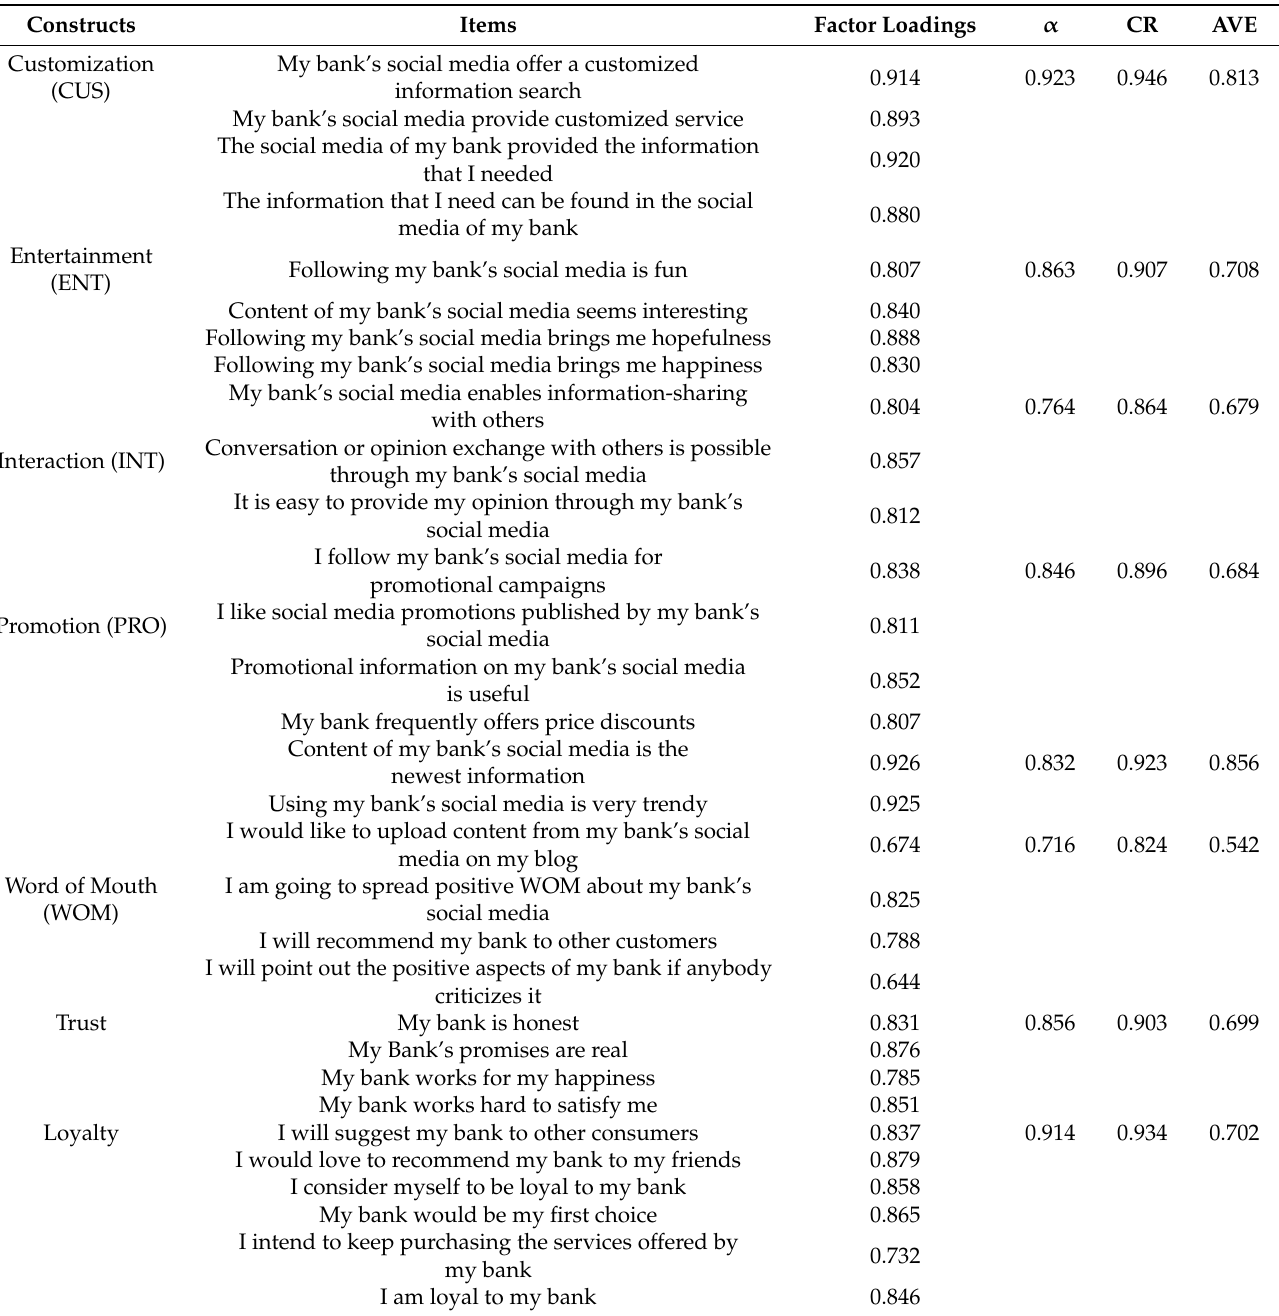
Table 2. Construct